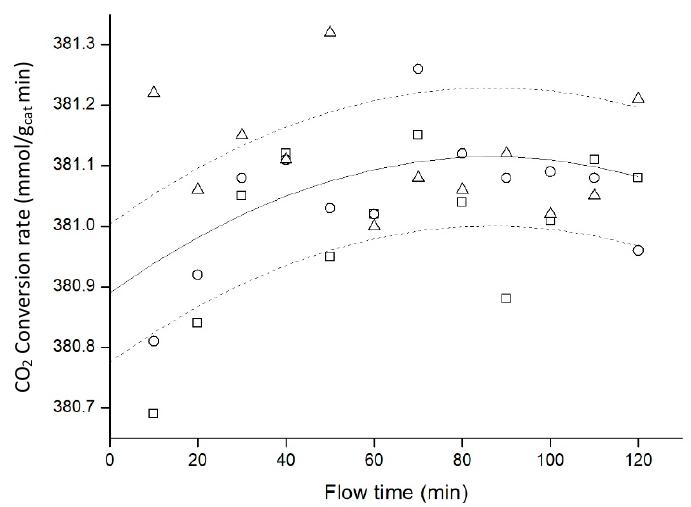
Figure 8. Influence of preheating temperature on the reaction.